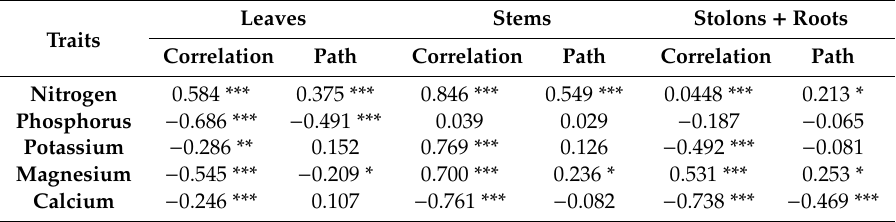
Figure 2. Path diagram of the impact of macronutrients ( A ) and micronutrients ( B ) contents in potato leaves at the onset of tuberization on the marketable tuber yield. ***, **, * significant at p < 0.001; < 0.01; < 0.05, respectively. Table 3. Correlation and path coe ffi cients for relationships between macronutrient content and tuber yield. ( n = 96).